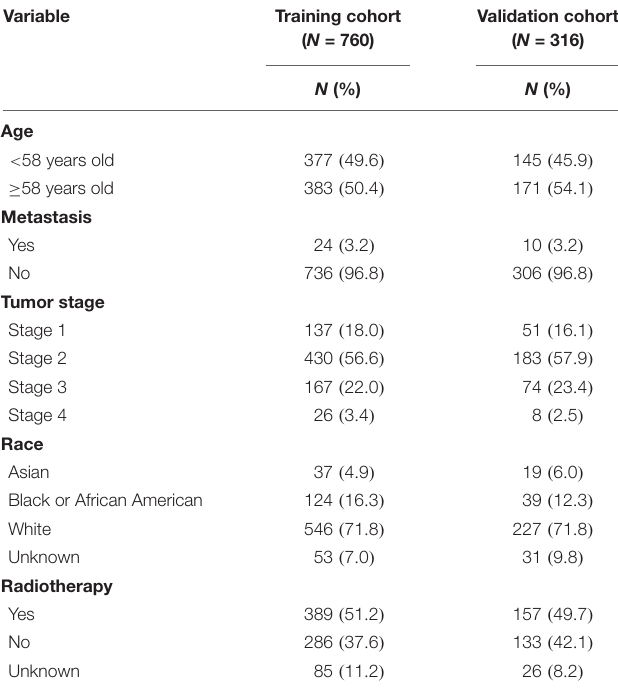
TABLE 1 | Clinical characteristics of samples.